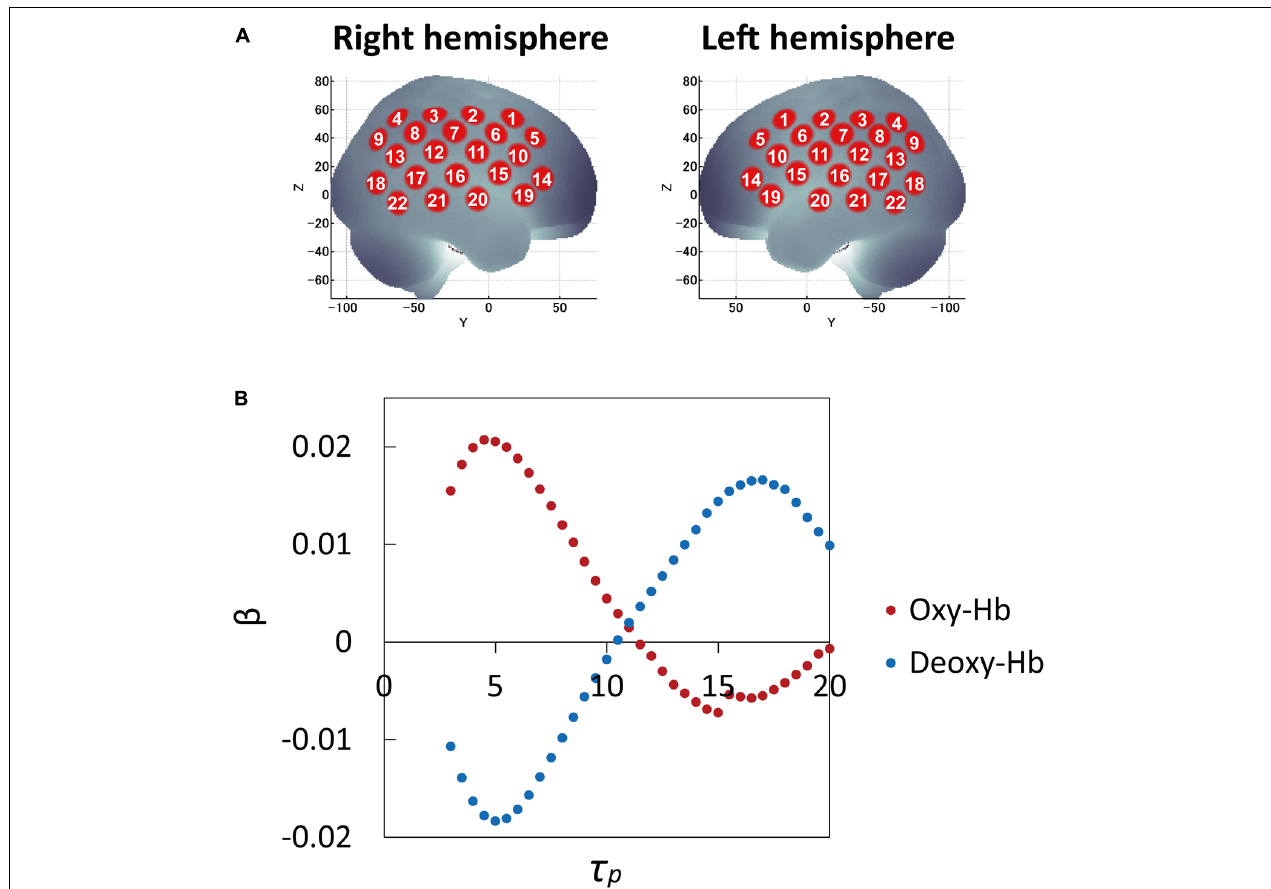
FIGURE 1 | Cortical projection points of fNIRS measurements and average β -values (response amplitudes) of the oxy-Hb and deoxy-Hb signals over 53 participants and three conditions as a function of peak latency τ p . (A) Cortical projection points of fNIRS measurements (location of 22 channels on each hemisphere) are mapped onto the MNI standard brain coordinate system using spatial registration. (B) To examine the effects of τ p , the average β -values over 53 participants and three conditions were calculated and compared for all τ p ranges for 44 channels. Channel 16 in both the left and right hemispheres in the vicinity of auditory cortex were included among the channels within the top 10% β -values of 22 channels in each hemisphere. Therefore, τ p was determined by averaging the τ p values at the highest β -values of channel 16 in both hemispheres: optimal τ p was 5 s for both oxy-Hb and deoxy-Hb signals.